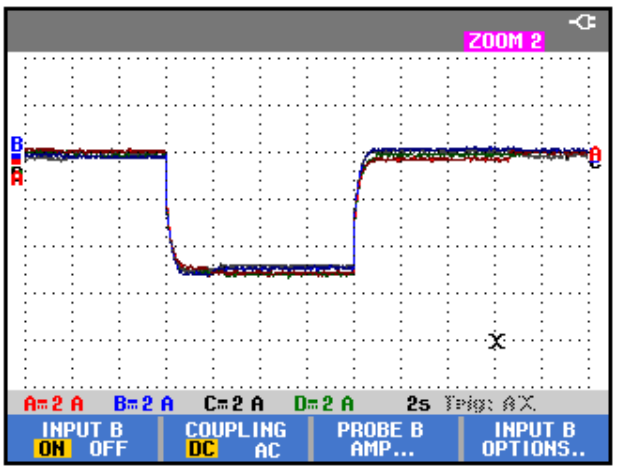
Figure 27. Mitigation signals during simultaneous current attacks.